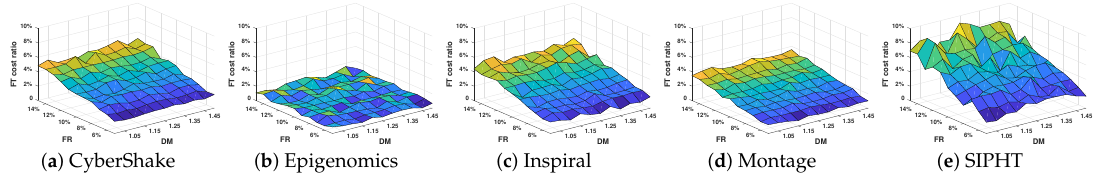
Figure 7. FT cost ratio of real-world workflows with increasing DM and decreasing